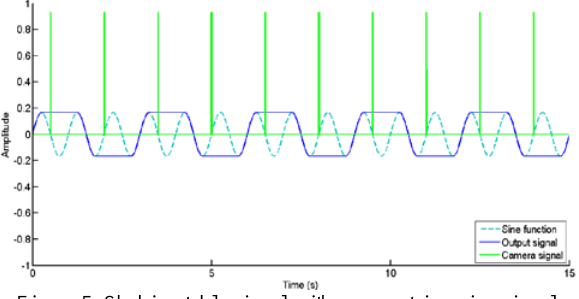
Figure 5. Shaking table signal with camera triggering signal.